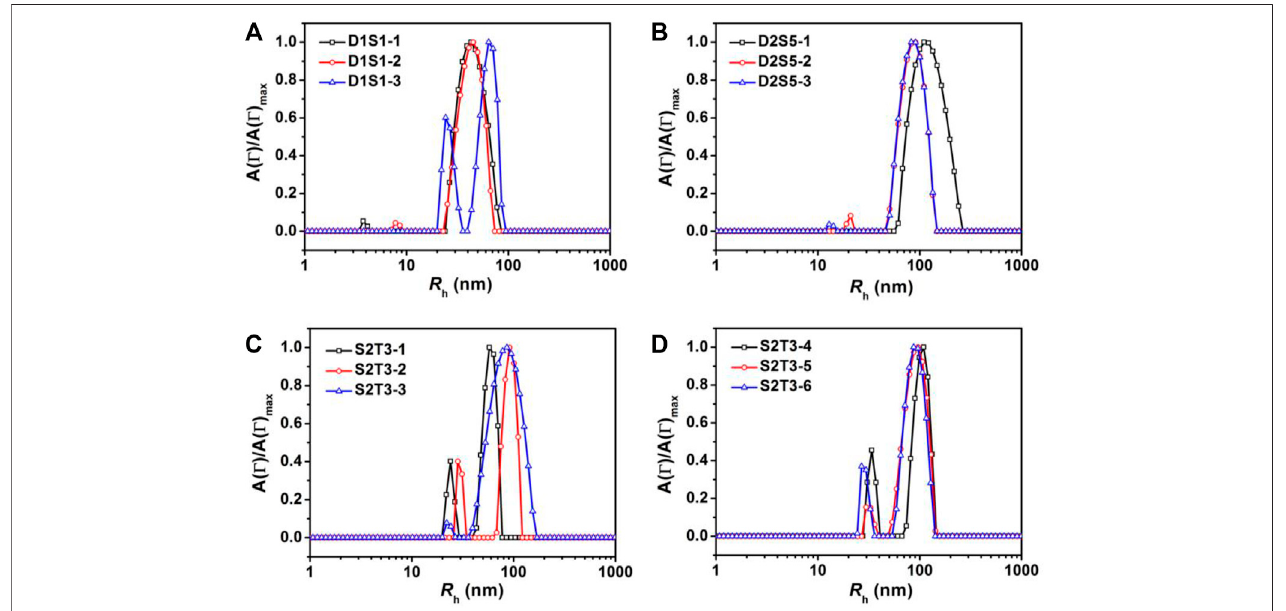
FIGURE 5 | Representative hydrodynamic radii, R h , distributions for mixtures of (A) D1+S1, (B) D2+S5, (C,D) S2+T3 in a methanol/THF (v:v = 3:1) mixture at C = 0.25 mg/ml. The IDs in the fi gure legends correspond to sample IDs given in Table 3 .